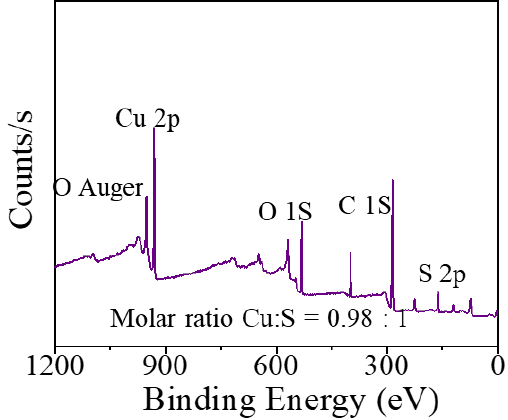
Figure 3. The XPS full spectra survey of c-CuS.